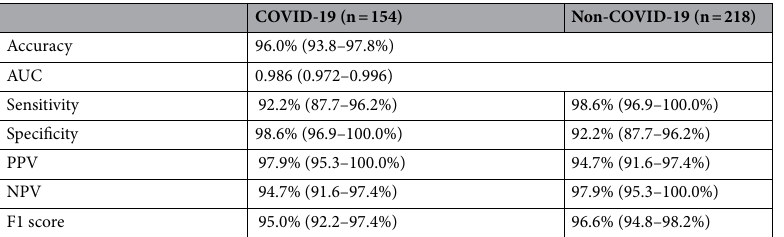
Table 1. COVIDNet diagnostic performance on the initial test dataset. 372 patients were considered, including 154 COVID-19 patients and 218 non-COVID-19 patients. The diagnostic metrics of accuracy, AUC, sensitivity, specificity, PPV, NPV, and F1 score were calculated as well as the corresponding CIs. AUC area under the ROC curve, PPV positive predictive value, NPV negative predictive value, CI confidential interval.